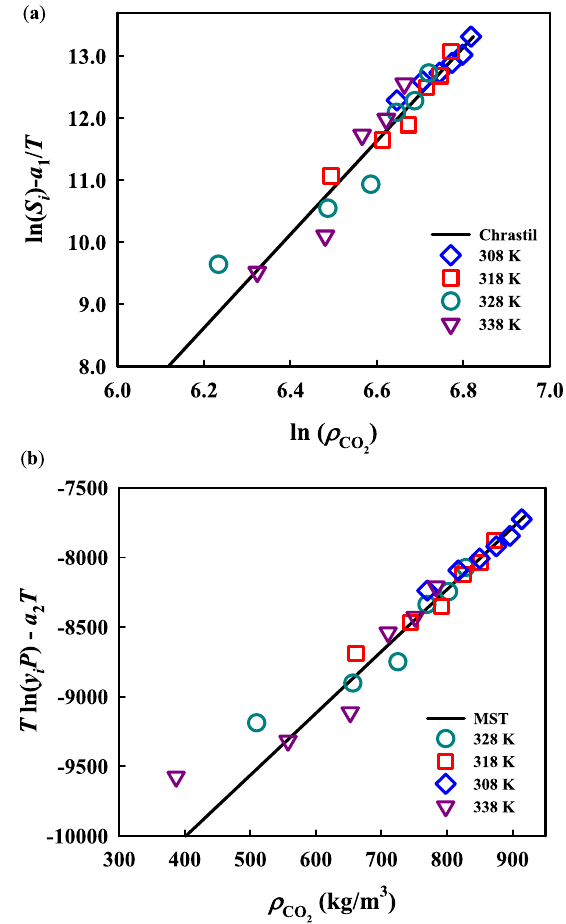
Figure 3. Self-consistency test for experimental data of palbociclib solubility in ScCO 2 using ( a ) Chrastil and ( b ) MST